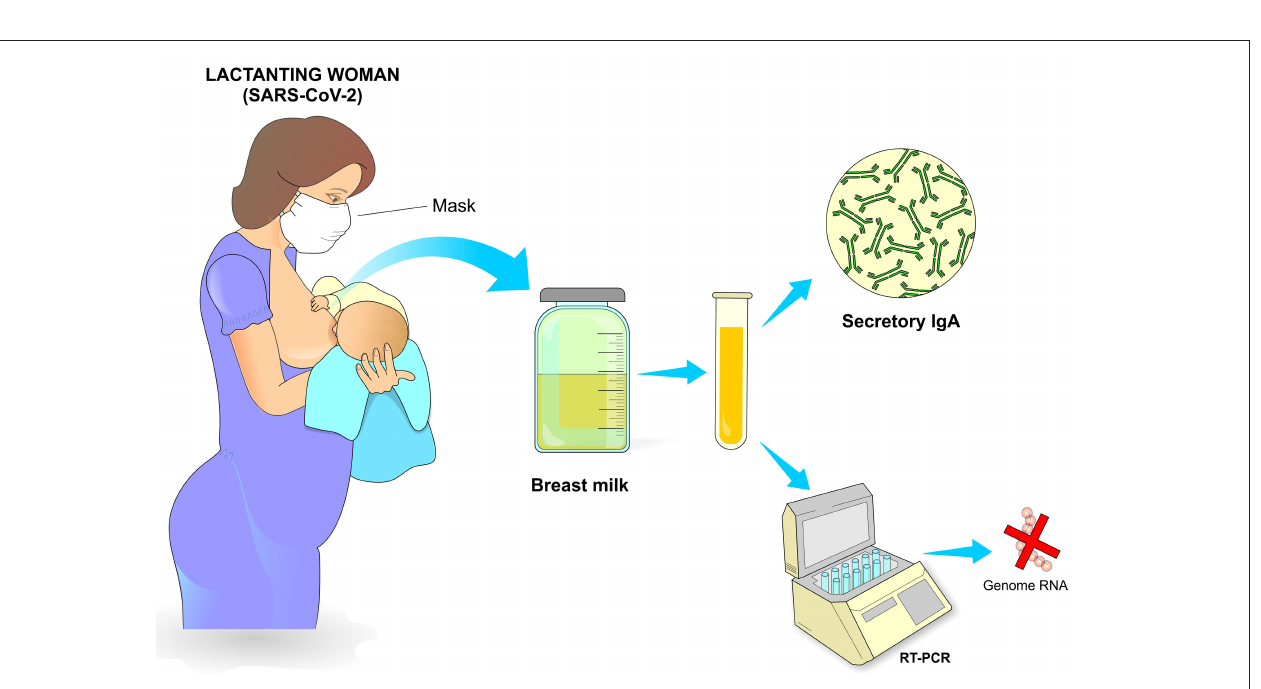
Frontiers in Global Women’s Health |